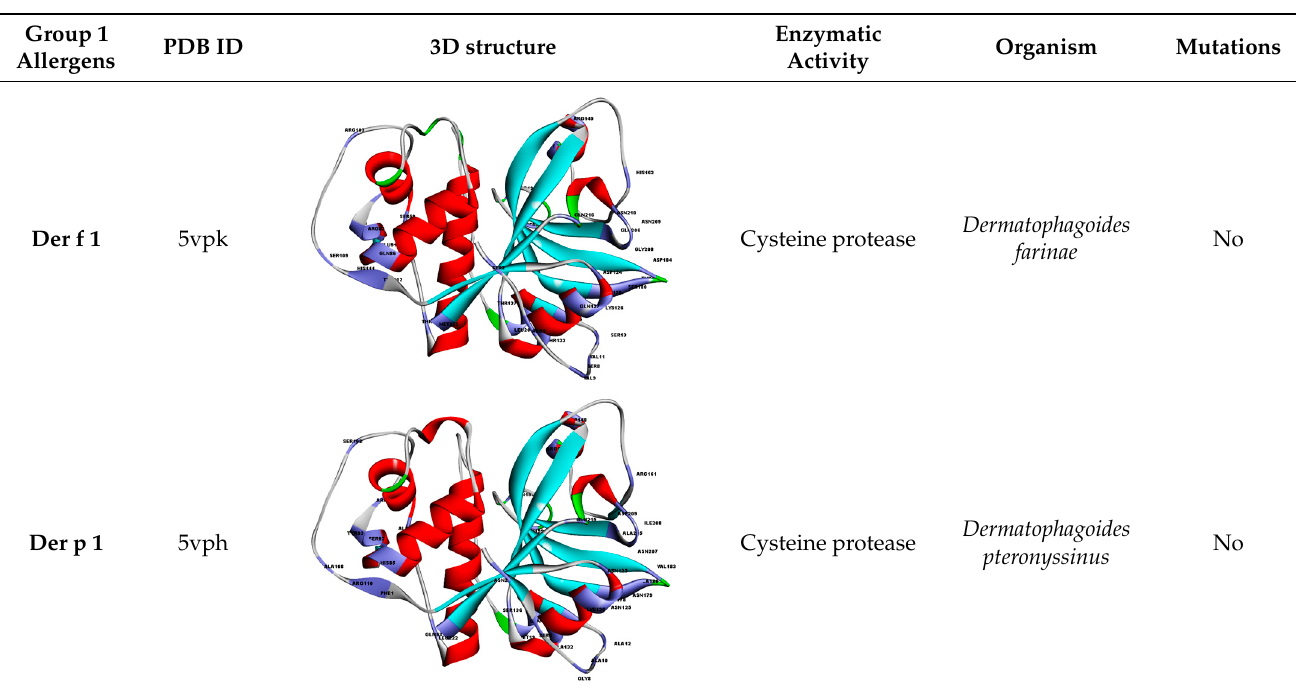
Table 2. Description of representative Group 1 HDM allergens.